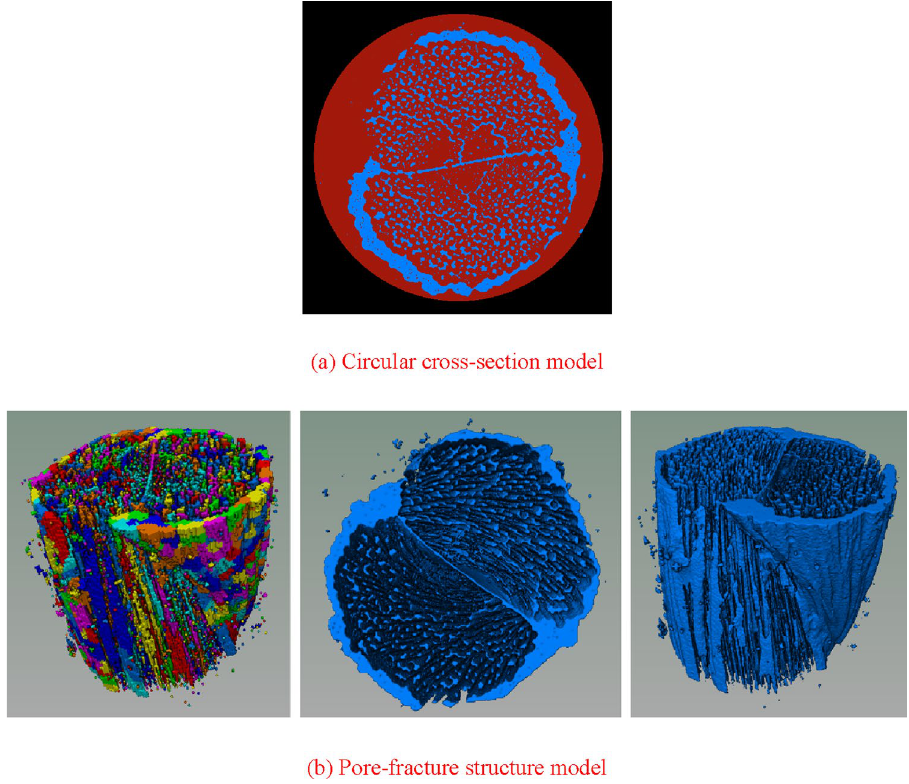
Figure 23. Three-dimensional distribution of the nylon-uncured rubber model.